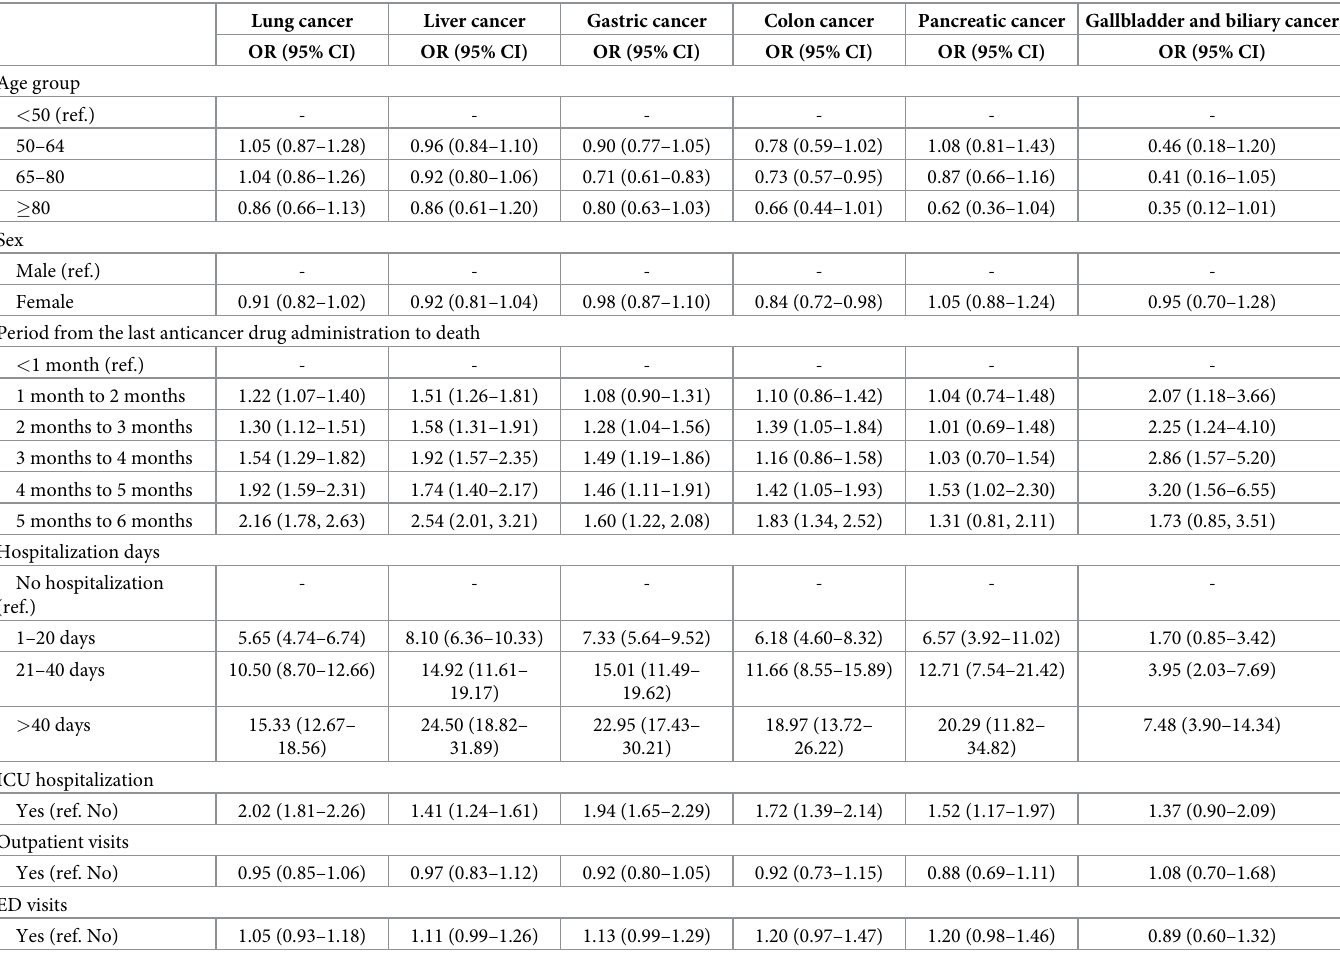
Table 4. Generalized linear model analysis evaluating the impact of demographic and healthcare utilization factors on medical costs during best supportive